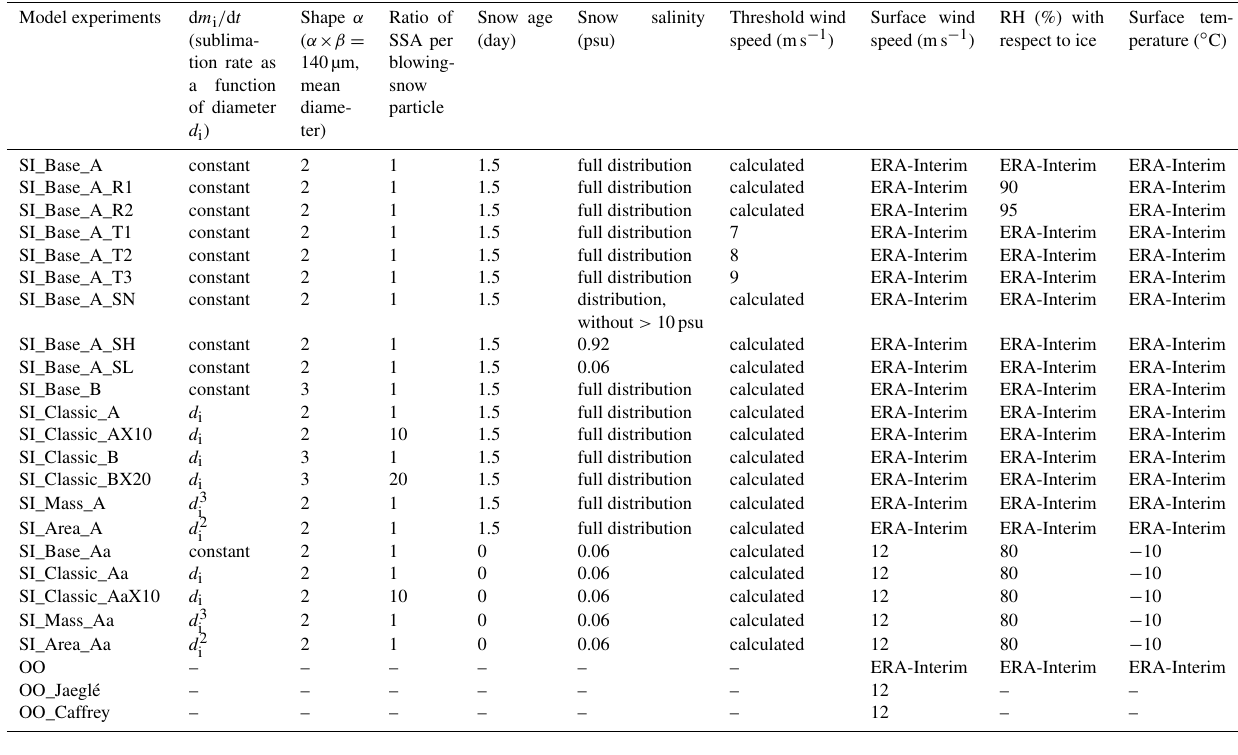
Table 1. Model experiments for sea-ice-sourced SSA (with SI in prefix of each experiment) and sea spray fluxes (with OO in the prefix). Columns 2–10 show parameters applied to each experiment: sublimation function, shape of the blowing-snow size distribution, ratio of SSA formed per blowing-snow particle, snow age, salinity, threshold wind speed, RH (with respect to ice) and air temperature. Model experiments